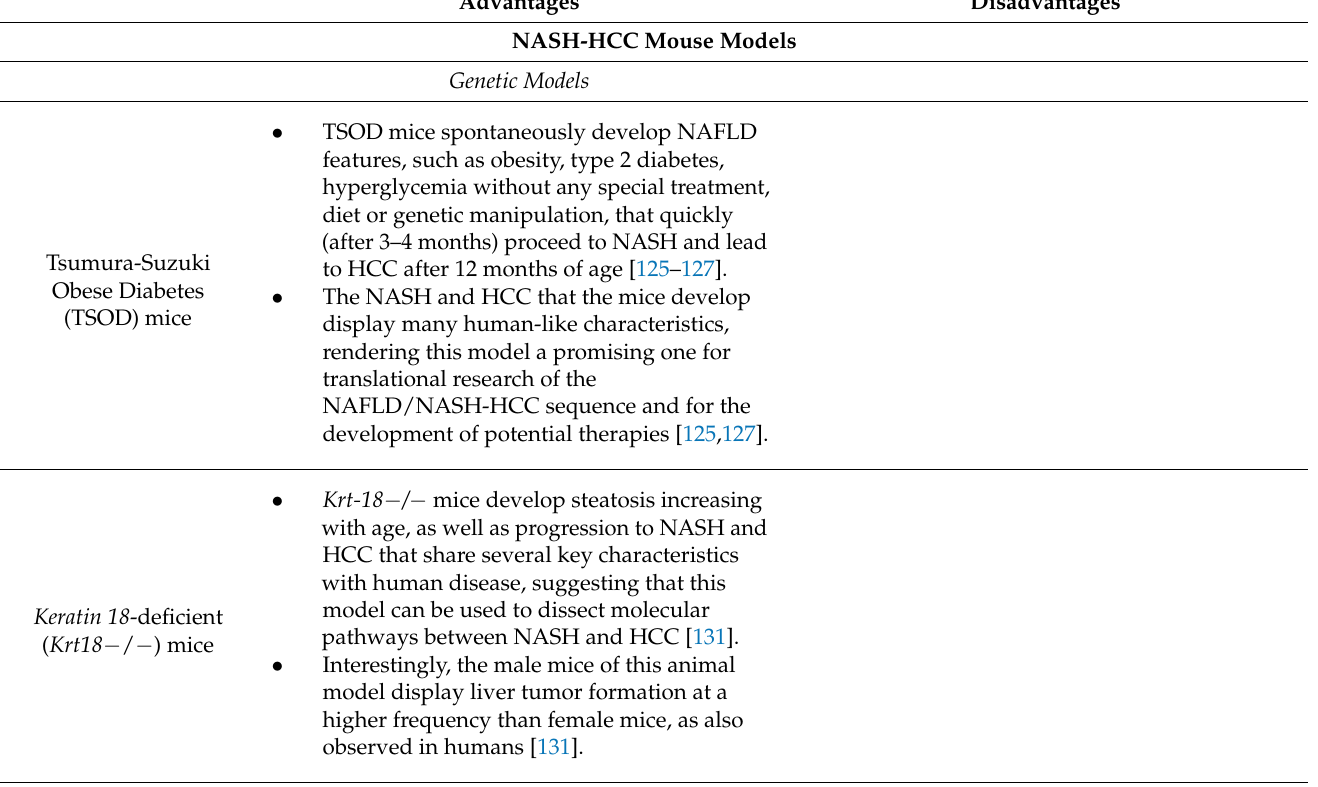
Table 1. Cont . Advantages Disadvantages NASH-HCC Mouse Models Genetic